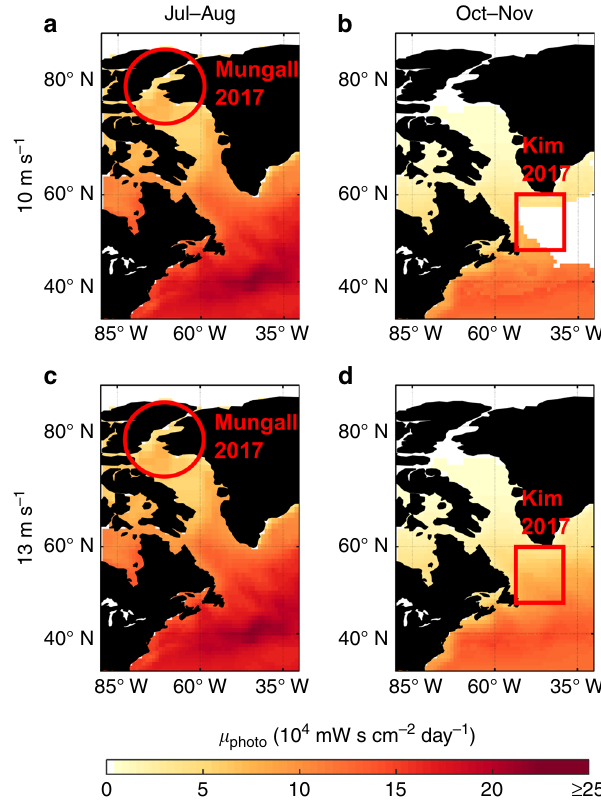
Fig. 3 VOC formation potential µ photo . For wind speed limits of 10 m s – 1 ( a , b ) and 13 m s – 1 ( c , d ) for the locations and periods of the studies by Mungall